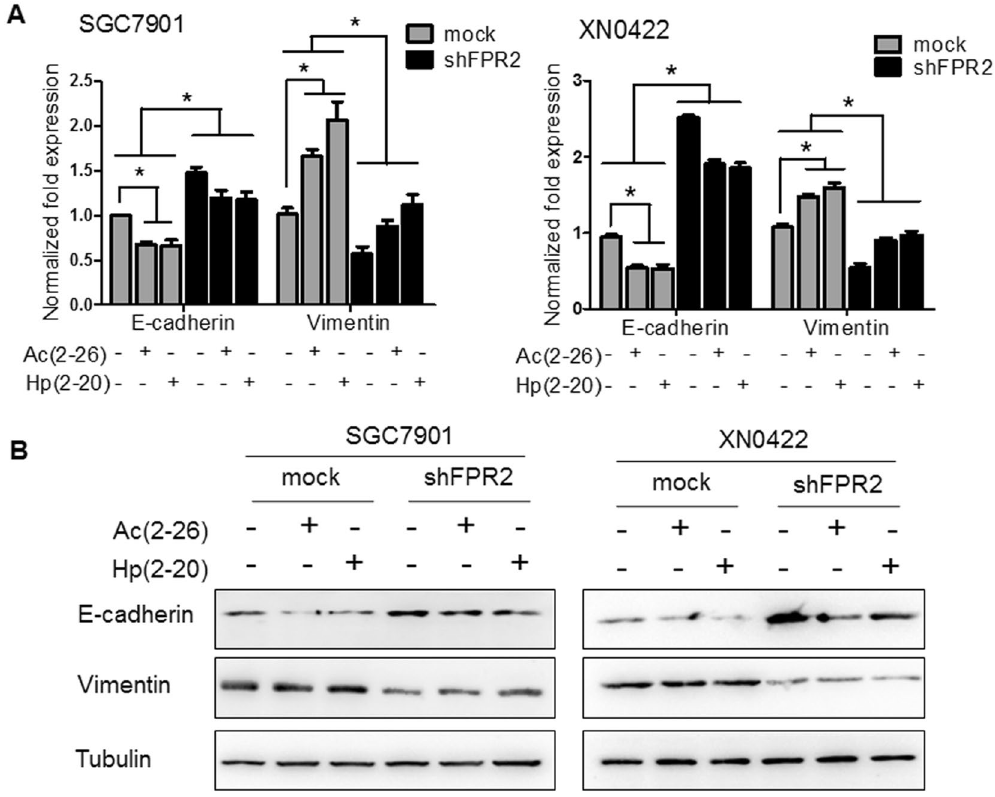
Figure 4. Activation of FPR2 is associated with the expression of EMT-related molecules in GC cells. ( A ) Stimulation with Hp(2–20) and Ac(2–26) (100 μ M for each) down-regulated E-cadherin and up-regulateed vimentin expression in SGC7901 cells (left panel) and XN0422 cells (right panel) detected by real-time PCR and normalized against GAPDH, but these effects are reversed by FPR2-knockdown. ( B ) Western blot assay showed the same consequence as A at protein